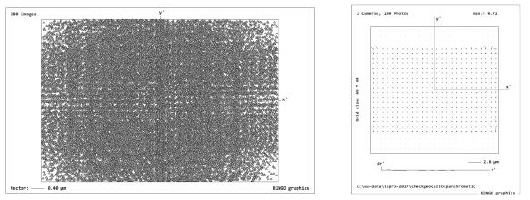
Fig. 6 a: Result from the Panchromatic Camera. The position of all measured target points in the image plane is illustrated on the left. The remaining image residuals after the calibration is shown on the right.